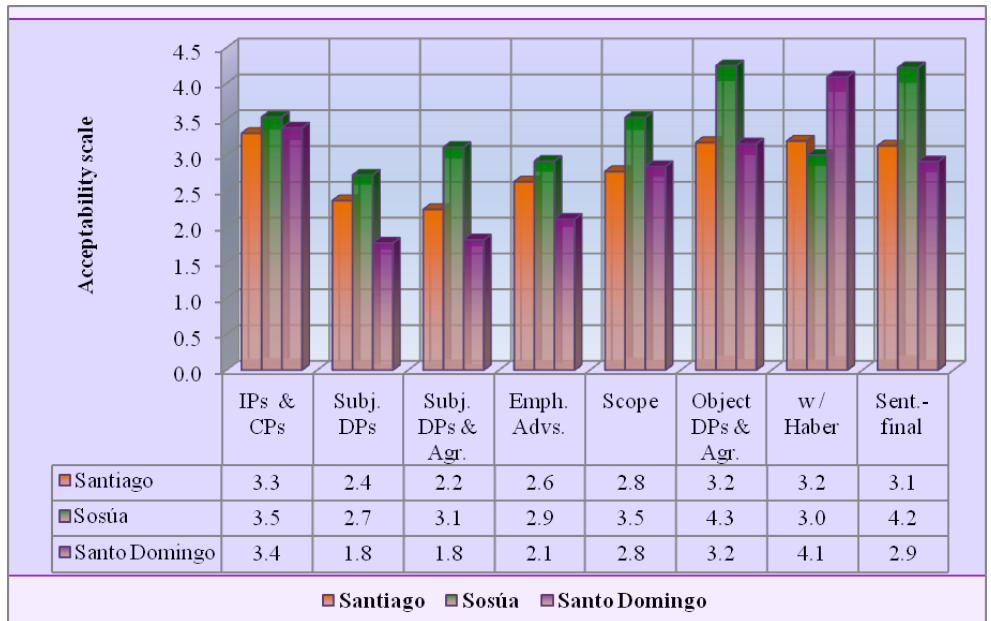
Graph 4: Summary of average ratings of FS by focus type in the second